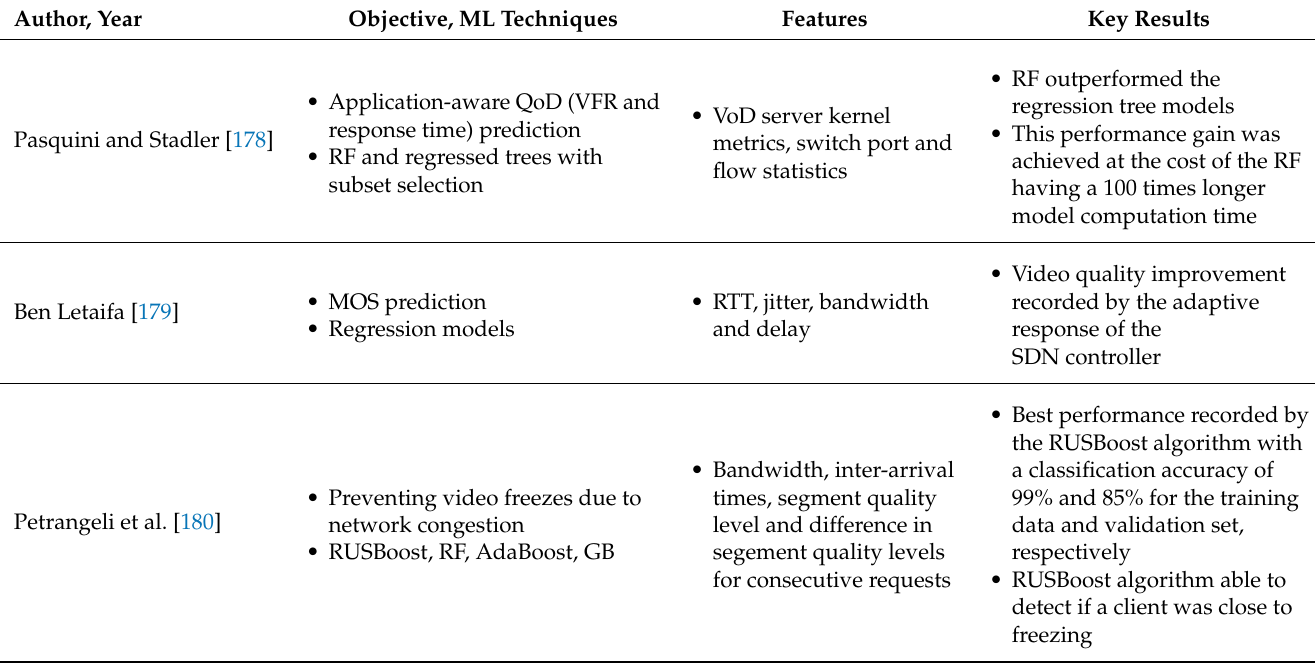
Table 5. Summary of QoD prediction in SDN